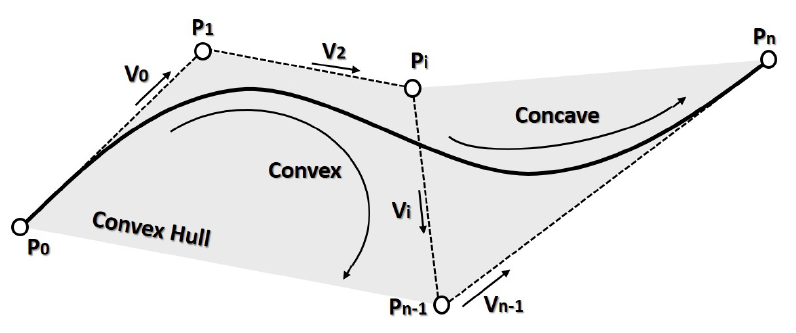
Figure 3. Bézier main